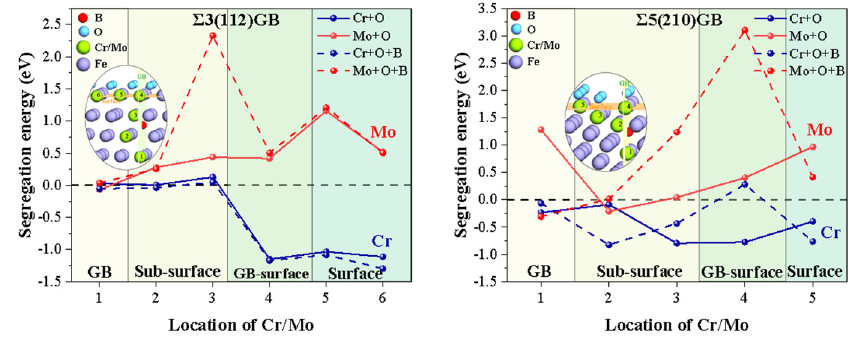
Figure 10. Microstructural models: the segregation energy of Cr and Mo diffusion to the surface in FCC–FeCrMo(–O–B)(111) with a Σ 3(112) GB and FCC–FeCrMo(–O–B)(100) with a Σ 5(210) GB.